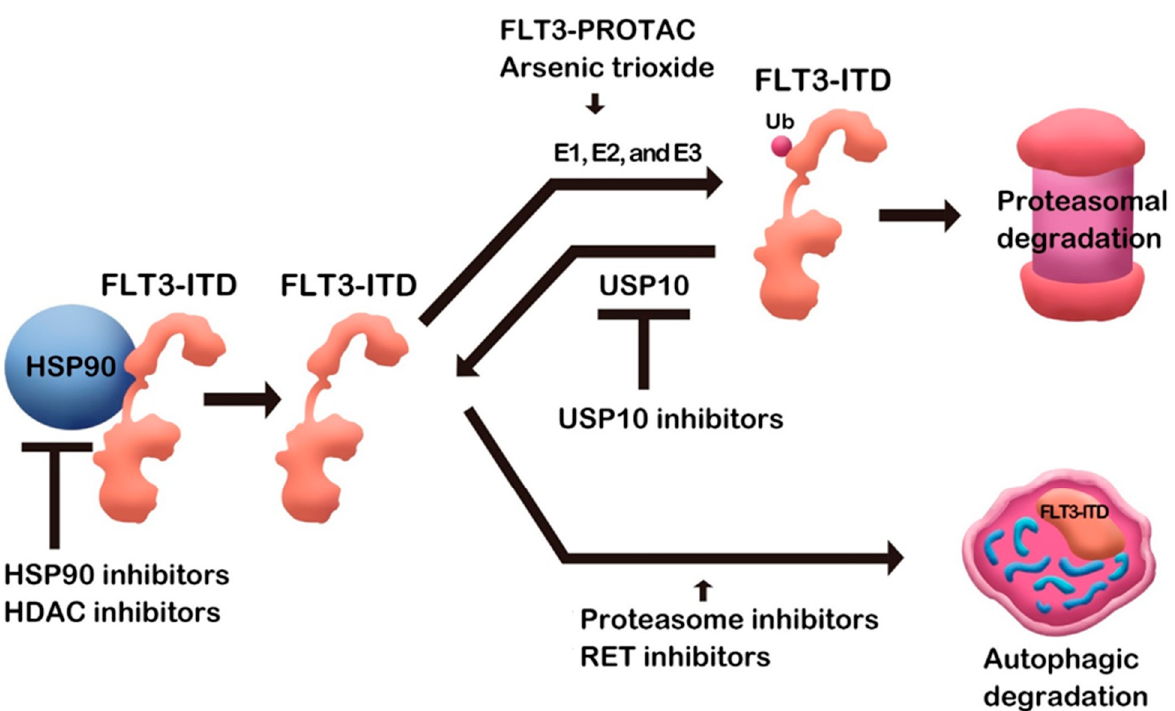
Figure 1. FLT3 degradation by small molecules. Table 1. Small molecules inducing FLT3 degradation.